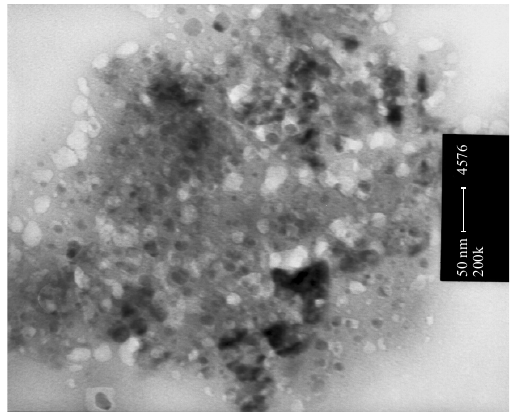
Fig. 2: TEM image of the nano-TiO powders obtained in the 2 maximum supersaturation at 70°C